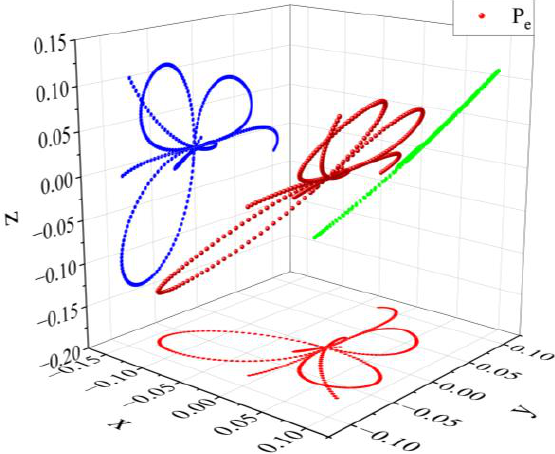
Figure 18. Trajectory of the end point of the offshore gangway with compensation control.